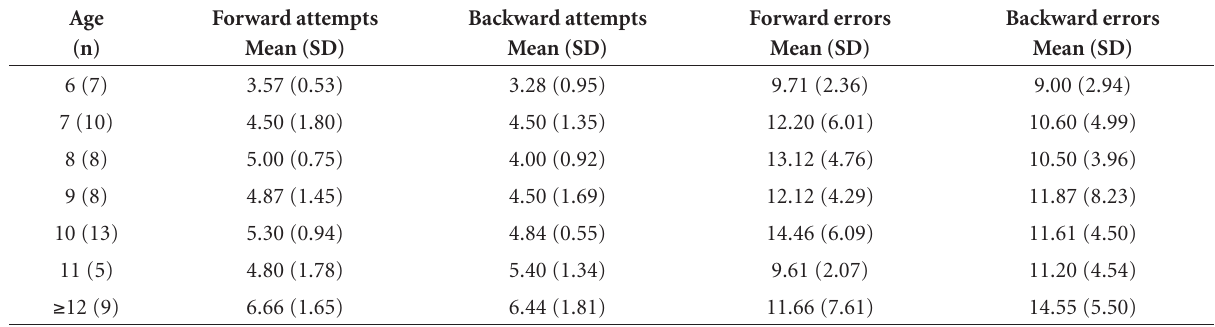
Table 4. Performance of different age groups.